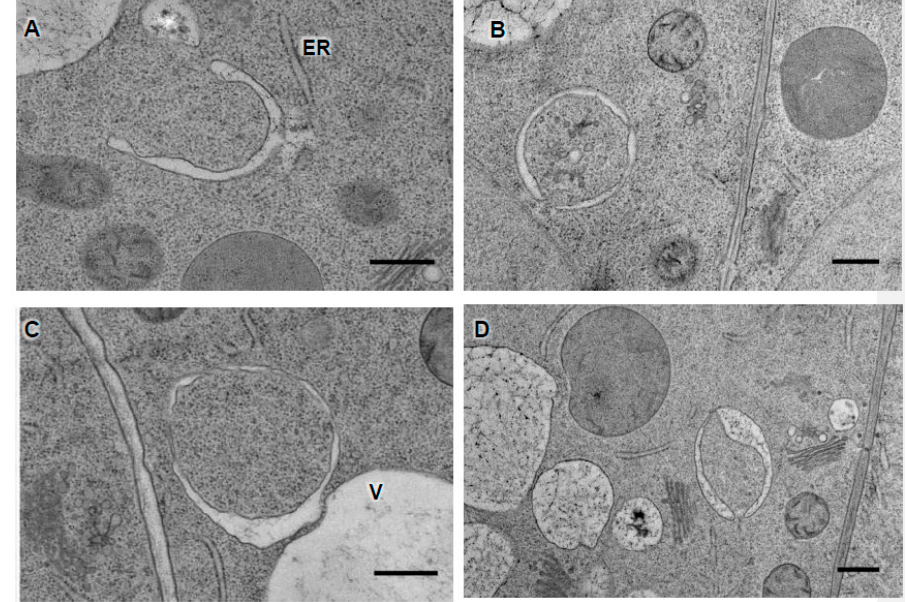
Figure 5. Growing phagophore and mature autophagosomal structures in Arabidopsis thaliana ( A ) Growing phagophore, close to the endoplasmic reticulum (ER); ( B ) sequestration of cytoplasmic components in a closing autophagosomal structure; ( C ) note the occurrence of a large space between the two membranes of the autophagosomes that may appear as a result of the sample processing for Electron Microscopy (EM); ( D ) autophagosome with membrane contact site with the vacuole (V). Scale = 500 nm. Root tips are prepared as described in Protocol 2, cryofixed, and embedded in EPON resin. Ultrathin sections (80 nm) were contrasted with uranyl acetate and lead citrate and observed by TEM at 120 kV.